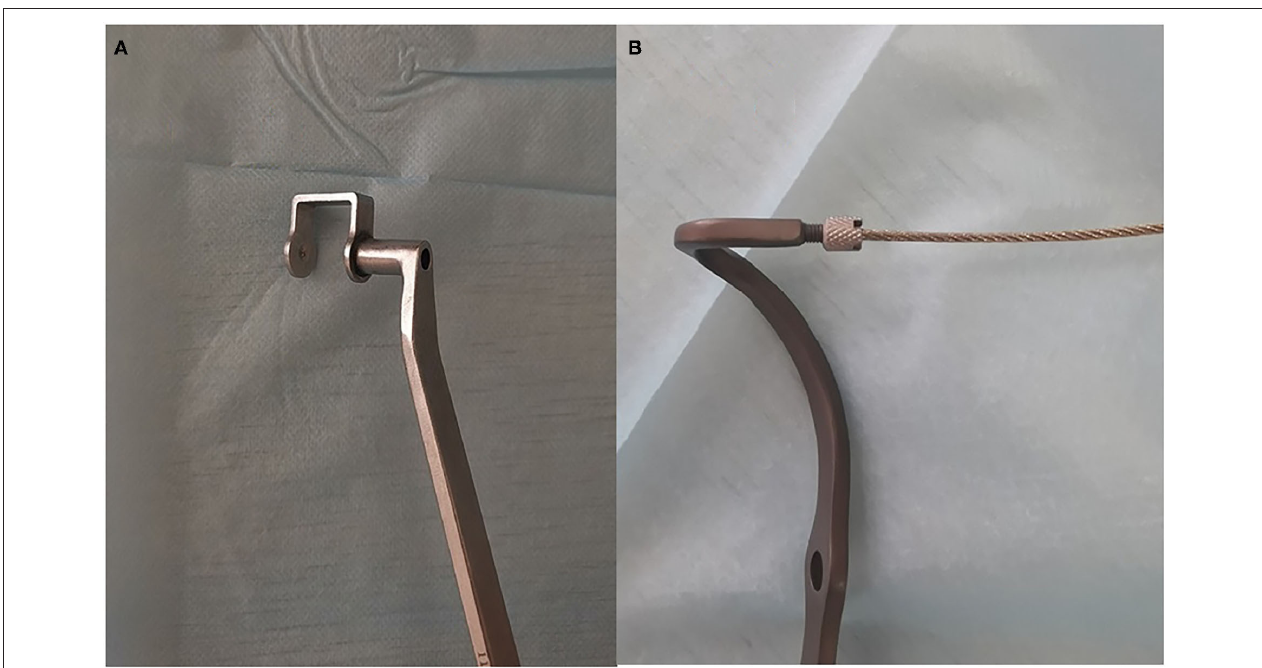
FIGURE 3 | Flow chart of included patients treated with the specific plate.